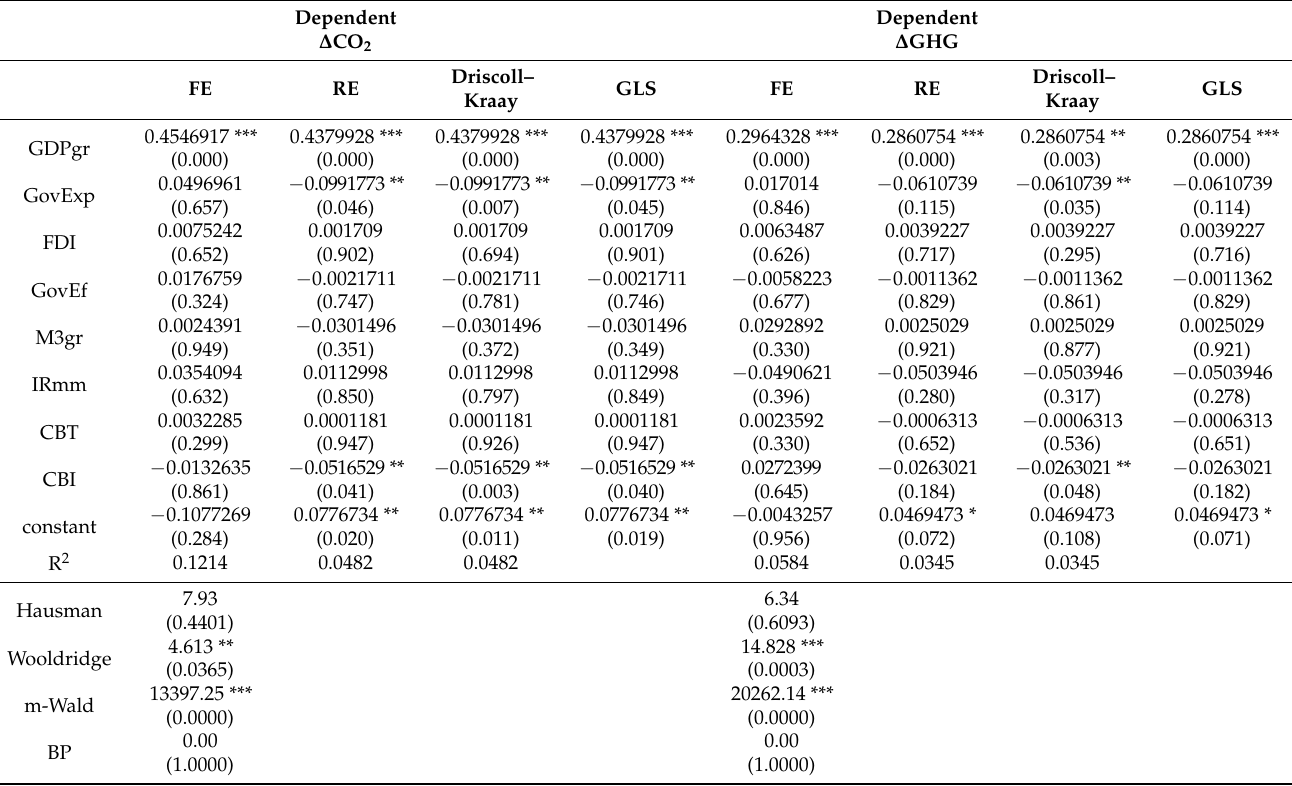
Table 7. Developing countries’ CO 2 and GHG